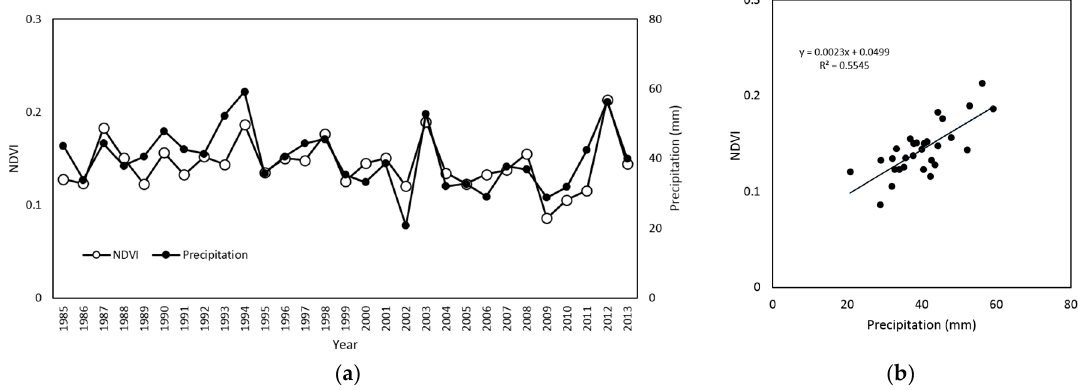
Figure 6. ( a , b ) Relationship between NDVI and precipitation during GS at Saikhan-ovoo site.